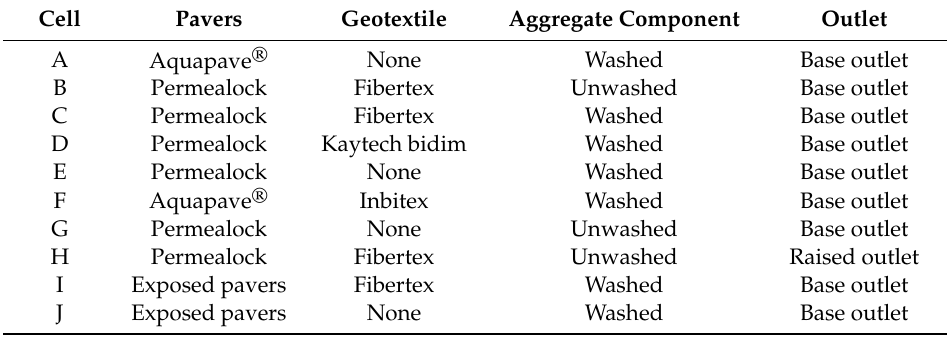
Figure 2. Typical cross-section of the permeable interlocking concrete pavement (PICP) test cells. Table 1. Permeable interlocking concrete pavement (PICP) test cell description.